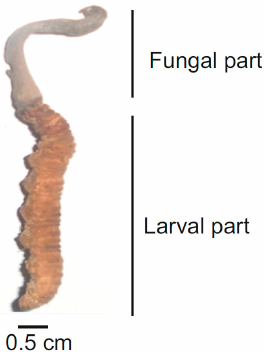
Figure 1 . Morphology of OS (polished sample immediately after harvesting). Figure 1. Morphology of OS (polished sample immediately after